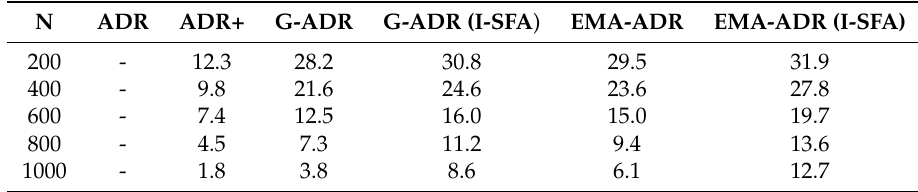
Table 7. PSR improvement for mobile EDs.